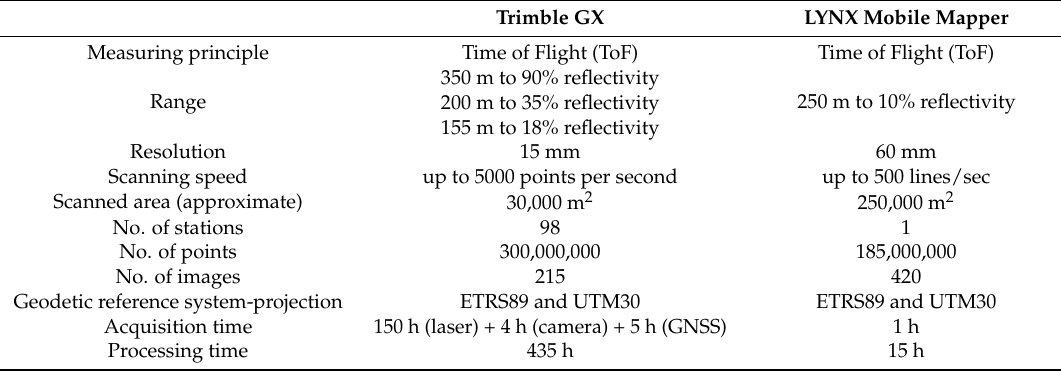
Table 4. Comparison between MLS and TLS field work and processed point cloud.